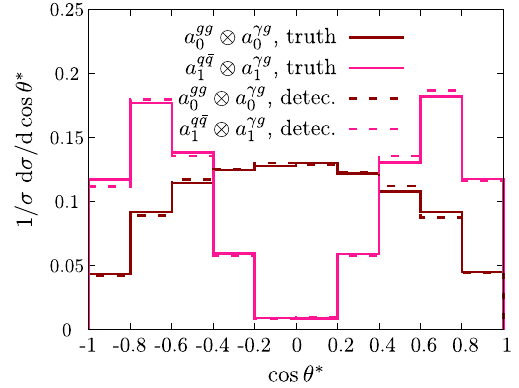
Fig. 7 Normalised cos θ ∗ and helicity angle distributions for jet+ Z production for the different spin and coupling properties as detailed in Sect. 2 (no jet-merging and detector resolution effects are included). We include the expected background distributions. See caption of Fig. 2 for further details on the